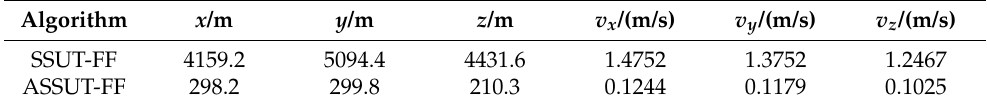
Figure 15. RMSEs of position and velocity in three directions at different noise levels. ( a ) RMSEs of the position in the X direction; ( b ) RMSEs of the position in the Y direction; ( c ) RMSEs of the position in the Z direction; ( d ) RMSEs of velocity in the X direction; ( e ) RMSEs of velocity in the Y direction; and ( f ) RMSEs of velocity in the Z direction. Table 12. Average RMSEs of position and velocity in three directions in the uncertain noise